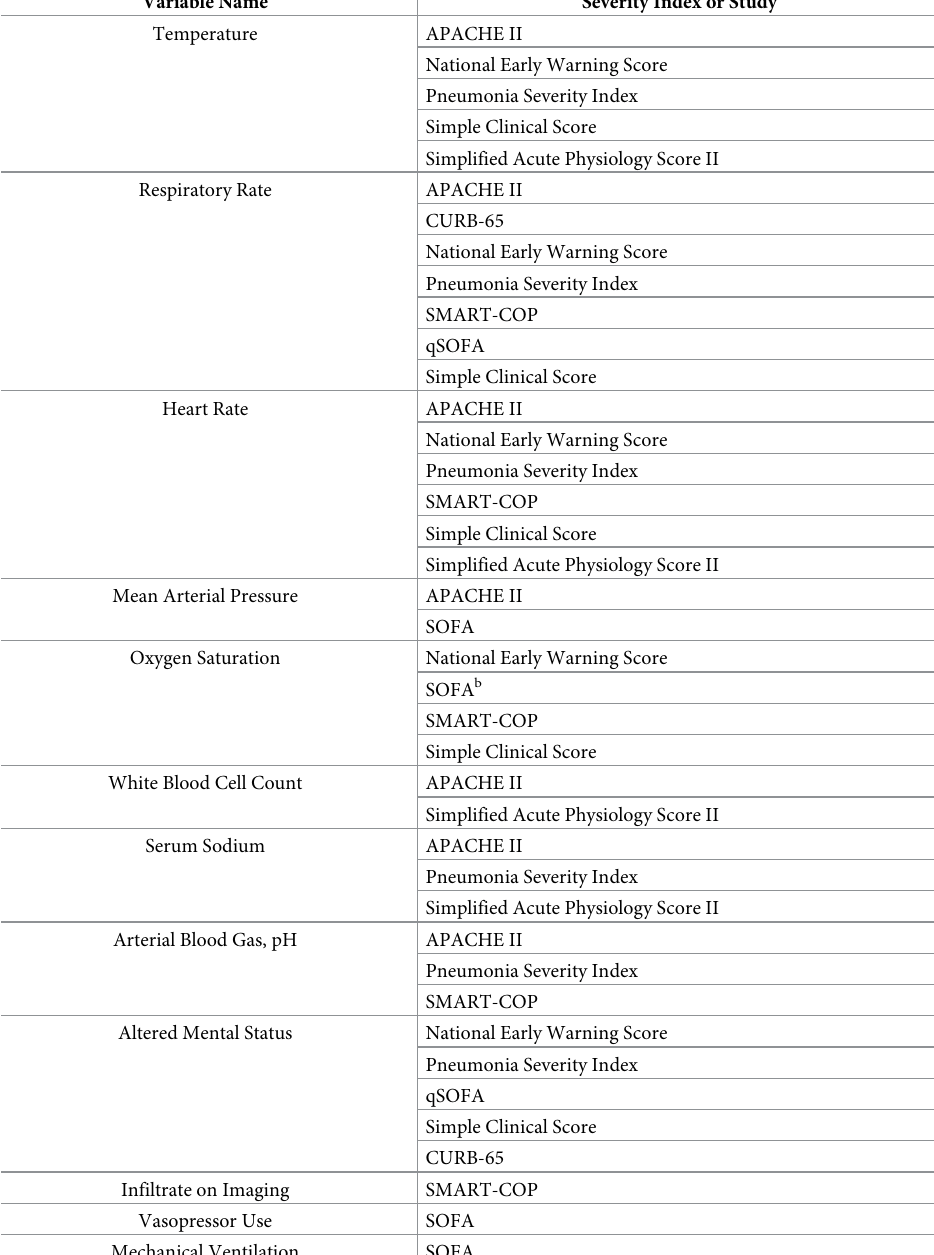
Table 1. Published severity scores a informing the physiologic features and interventions for the Influenza Disease Evaluation and Assessment of Severity (IDEAS)